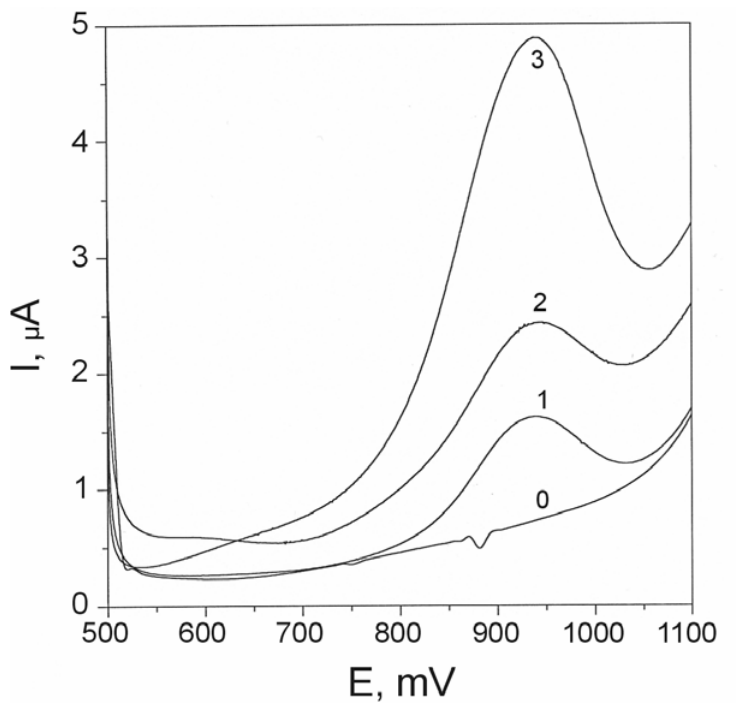
Figure 3. DP voltammograms of [Ru(bpy) after (3) incubation in cleavage mixture of 6x10 -3 mol/L arsenite, 2x10 -4 mol/L Fe(II) and 1.5x10 -2 mol/L H O for 10 min. Conditions: 5x10 -6 mol/L Ru(bpy) 2 2 pH 5.40 with 5x10 -2 mol/L NaCl, scan rate 1